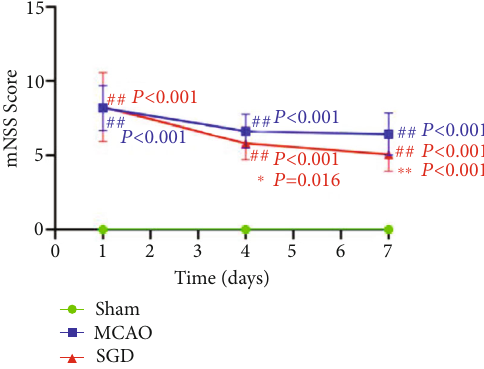
Figure 3: SGD alleviated neurological impairments following CI/ RP in rats. Before humane sacri fi ce, all rats in the sham, MCAO, and SGD groups underwent the neurological evaluation named mNSS at 1 d, 4d, and 7d post-surgery. Data are expressed as mean ± SD , n = 16 rats per group. ## P < 0 : 01 vs. sham; ∗ P < 0 : 05 , ∗∗ P < 0 : 01 vs.